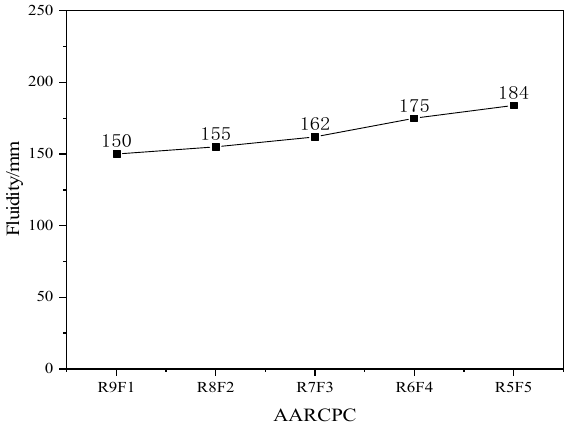
Figure 1. Fluidity of AARCPC with different fly ash content.